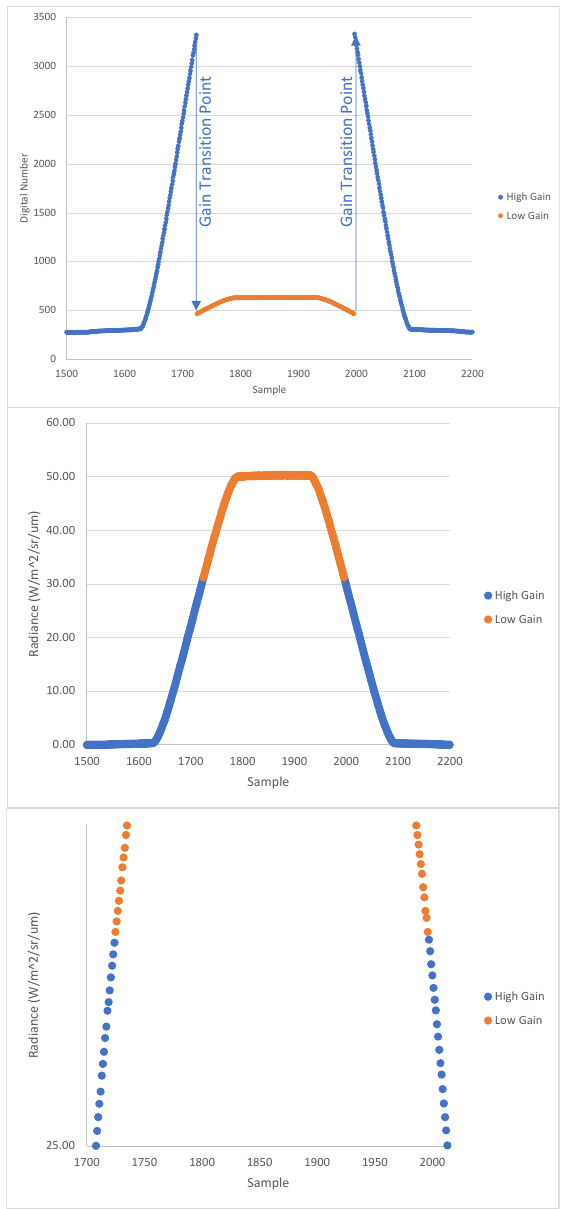
Figure 10. Band M7 digital numbers (DNs) as a function of scan during prelaunch testing (upper image). The pattern shows the detector’s response to the SIS100 profile as it scans across it in auto gain mode. The wings on the left and right are high gain DNs (blue line), where the detector is partially viewing the SIS100 aperture. When the DNs reach the gain switch point value, the detector switches to low gain and the DNs drop in the middle of the image (orange line). The M7 radiance is shown in the middle image and is the upper image DNs’ converted radiance using the prelaunch calibration coefficients. The lower image is a zoom-in of the gain transition point to show that it is continuous in radiance.